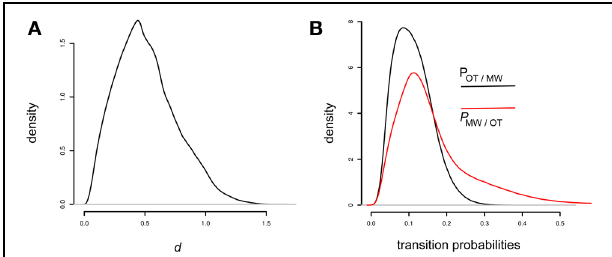
FIGURE 5 | (A) Overall posterior distribution of the parameter d in the exponential model, pooled across all 47 participants (60000 samples per participant). Note that the prior was uniform over [0, 2]. (B) Overall posterior distribution of the two transition probabilities in the exponential model. The prior was uniform over [0, 1] (60000 samples per